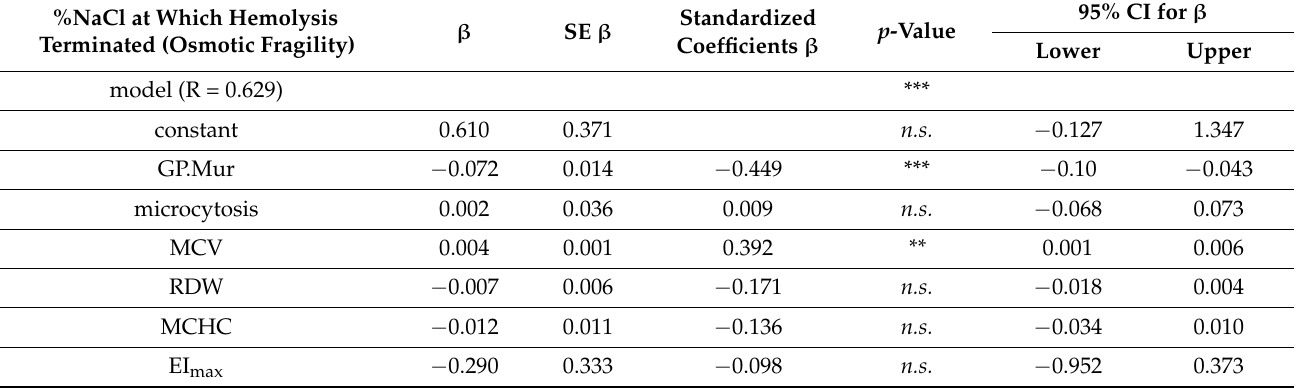
Table 6. A multivariate regression model for osmotic fragility included GP.Mur phenotype, microcytosis, MCV, RDW, MCHC, and EI max , as the independent variables. Osmotic fragility was represented by %NaCl at which hemolysis terminated. This model with R ~ 0.629 presented a good level of prediction for osmotic fragility, with two significant contributors—MCV and GP.Mur phenotype ( *** p < 0.001; ** p < 0.01). The former factor MCV promoted osmotic fragility of red cells (positive standardized β ). The latter factor GP.Mur reduced osmotic fragility (negative standardized β ). This model also showed that osmotic fragility was independent from other CBC parameters (MCHC and RDW), microcytosis, or EI max ( p > 0.05). n.s ., not